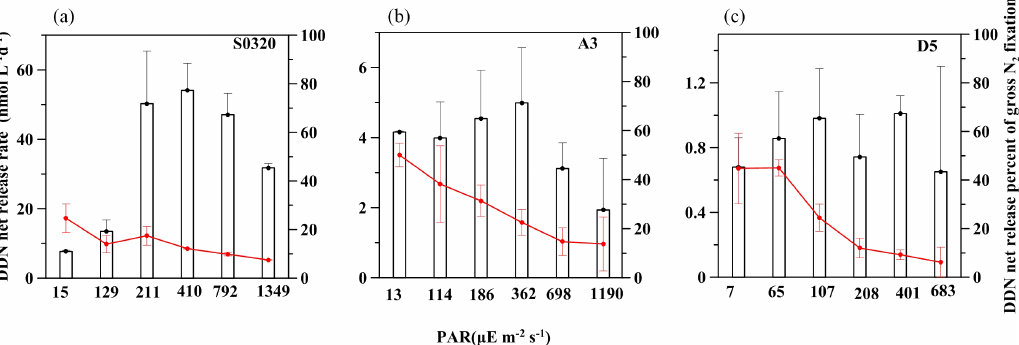
Figure 5. DDN net release rate (bar charters) and percentage of total NF (red lines) under different light intensities for stations S0320, A3 and D5. Error bars represent the standard deviation of triplicates.